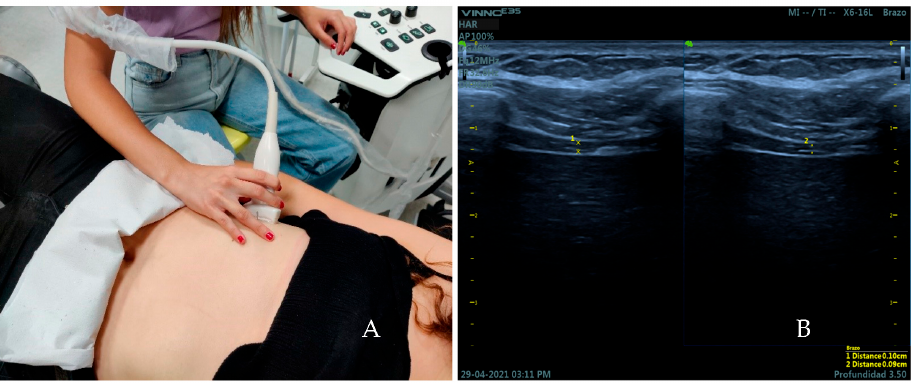
Figure 1. ( A ) Placement of the transducer over the area of apposition of the right hemidiaphragm for the measurement of the thickness of the diaphragm. ( B ) Ultrasound image obtained over this area. Distance 1 corresponds to the thickness of the diaphragm at the end of inspiration. Distance 2 corresponds to the thickness of the diaphragm at the end of expiration.